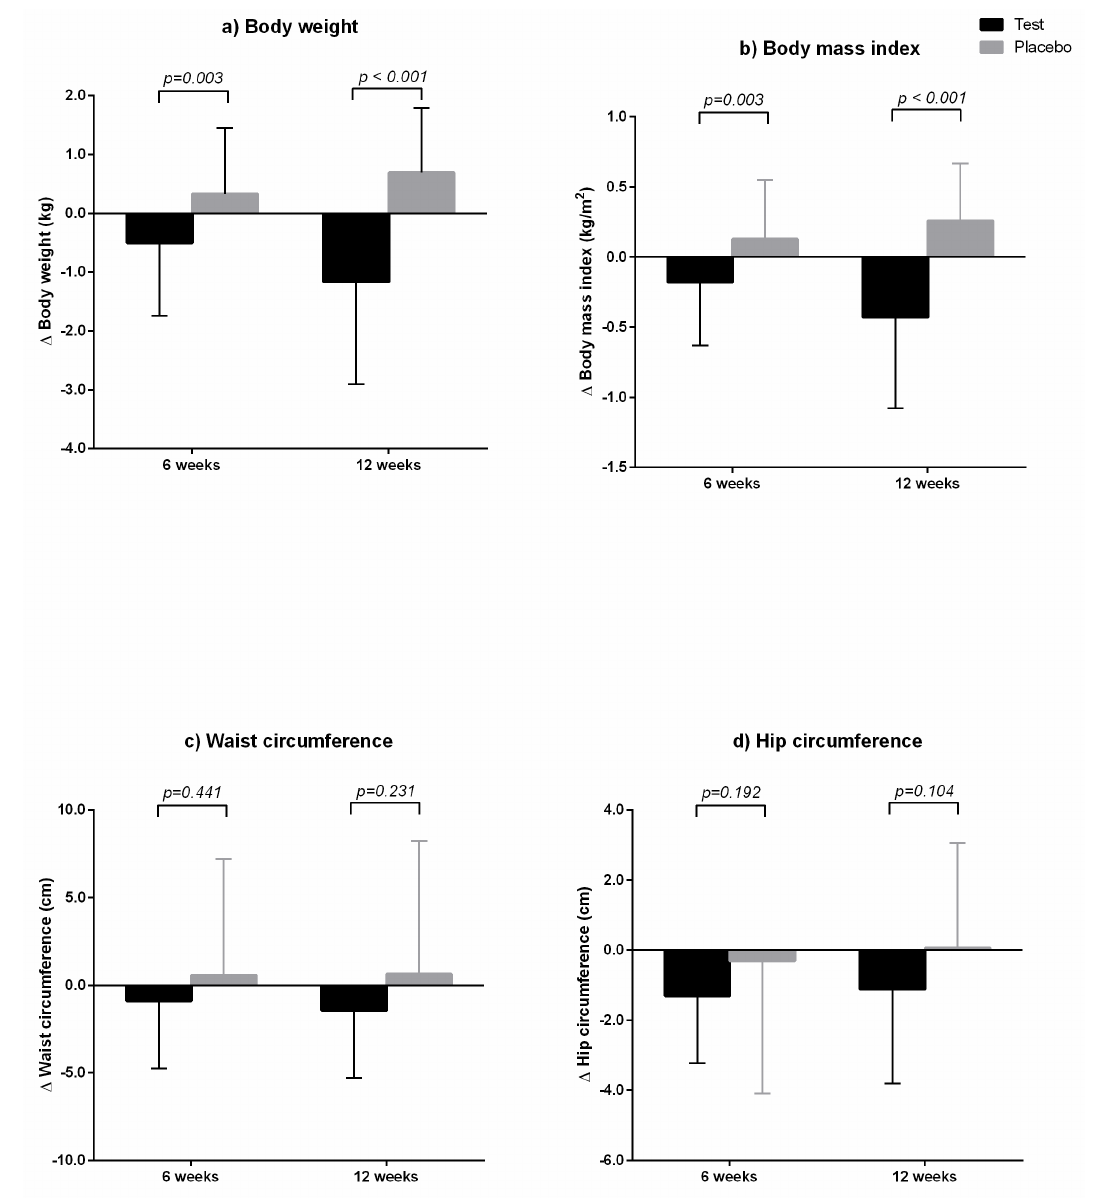
Figure 3. Changes in anthropometric parameters from baseline between the two groups at six and 12 weeks. The test group was administered Gelidium elegans extract 1000 mg/day for 12 weeks, and the placebo group was administered placebo. ( a ) Body weight; ( b ) body mass index; ( c ) waist circumference; and ( d ) hip circumference. p -values were calculated using ANCOVA test adjusted for baseline value, calorie intake, and physical activity.